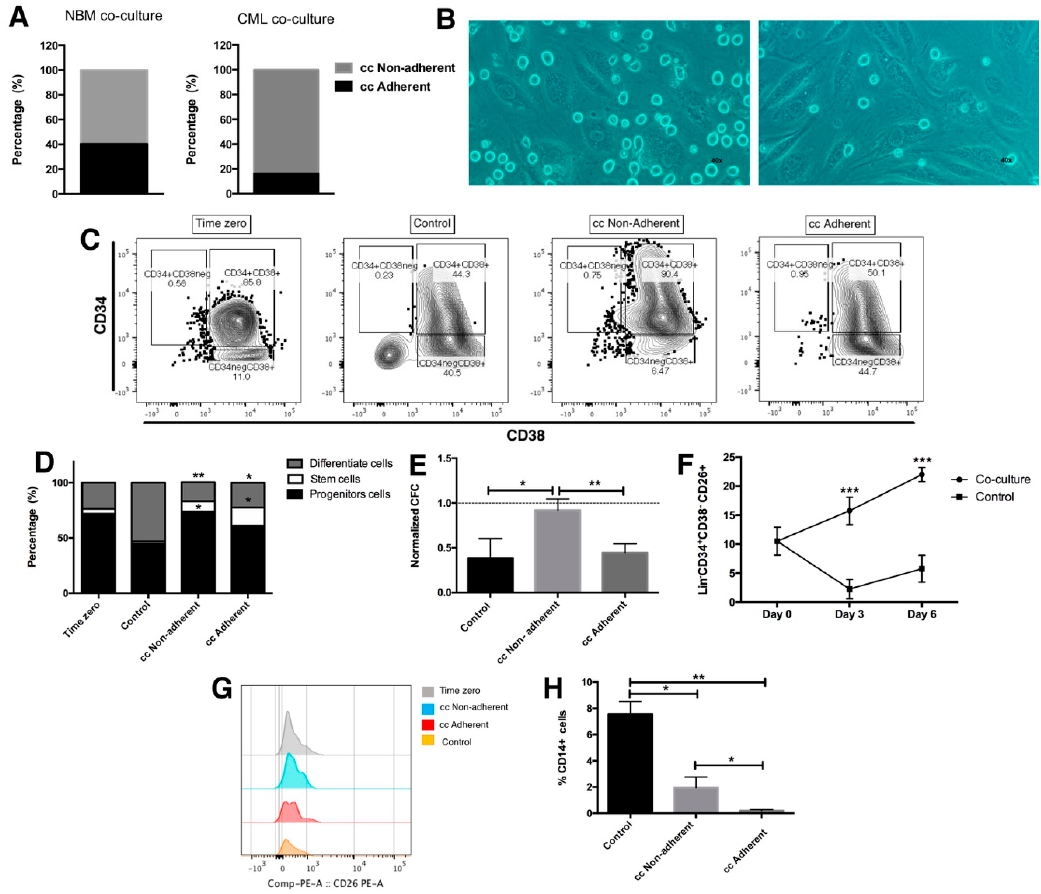
Figure 2. CML primitive cells had different affinity to endothelial microenvironment. Lin-CD34+ cells from CML patients were co-cultured in contact with EC for three days in absence of any cytokines to identify CML sub-fractions. ( A ) Percentage of adherent and non-adherent hematopoietic fractions in CML and NBM contact co-cultures. ( B ) Representative photographs of a co-culture with both adherent (right) and non-adherent (left) cell fraction. ( C ) Representative dot plot and ( D ) percentage of different CML populations (differentiate Lin+CD34-; progenitor CD34+CD38+ and stem CD34+CD38- cells) at the beginning of the experiment (zero time) and after three days in the absence (control) or presence of contact with EC where the adherent and non-adherent fraction were analyzed individually. ( E ) After three days of co-culture, 3,000 hematopoietic cells were sub-cultured in methyhlcellulose for 14 days and CFC was evaluated. The number of colonies was normalized with respect to the initial CFC in each sample used at the beginning of the experiment. ( F ) CML stem cells CD26+ (Lin-CD34+CD38-CD26+) were evaluated after 3 and 6 days of co-culture in a total population as well and ( G ) in adherent and non-adherent fractions. ( H ) The percentage of CD14+ myeloid cells were also determinate. The data are expressed as mean ± SEM ( E , F , H ) or mean ( A , D ) of 3–4 independent experiments by triplicate. * p ≤ 0.05, ** p ≤ 0.005, ***p ≤ 0.0005.